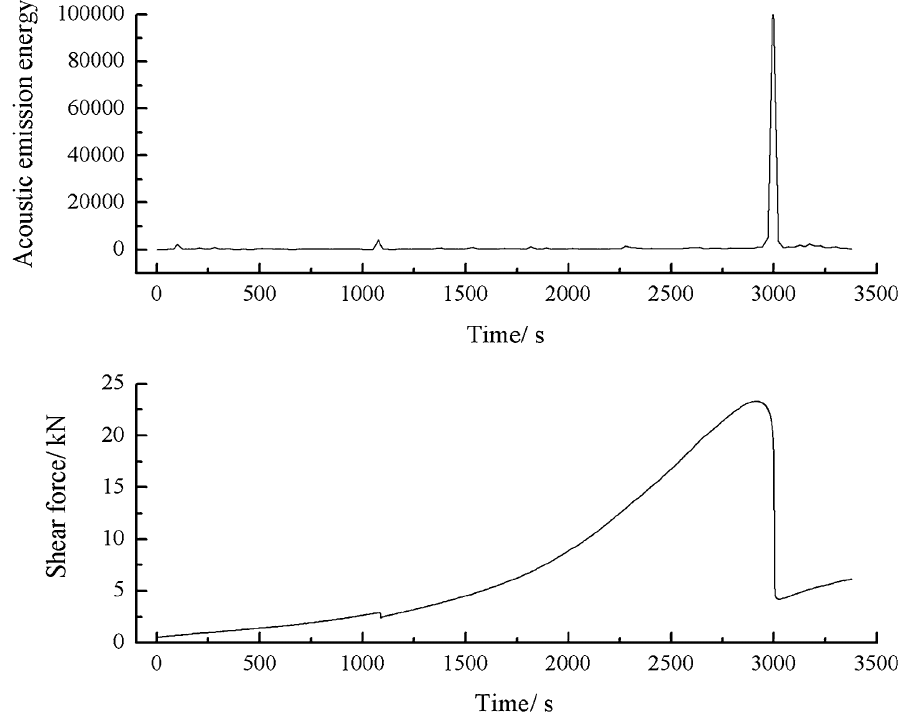
Figure 58. Shear stress–time and energy-time curves for a specimen containing 0–2.56 mm sand particles (produced from three grain size ranges).